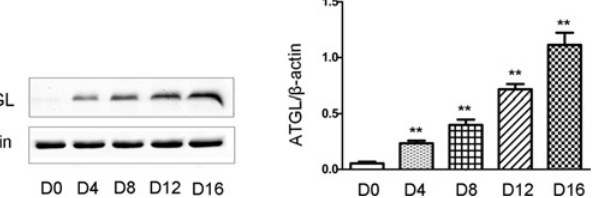
Figure 2. TSH stimulated ATGL protein expression in 3T3-L1 during the process of differentiation. Proteins were extracted from 3T3-L1 cells during the differentiation process every other day. Solubilized proteins were separated by SDS-PAGE and immunoblotted for ATGL and β -actin as indicated. Representative Western blot results are shown. The relative ATGL protein levels were quantified by densitometry and normalized with β -actin. The data are presented as the mean (cid:2) SD. ** p < 0.01 versus control group. Original magnification: 400×.